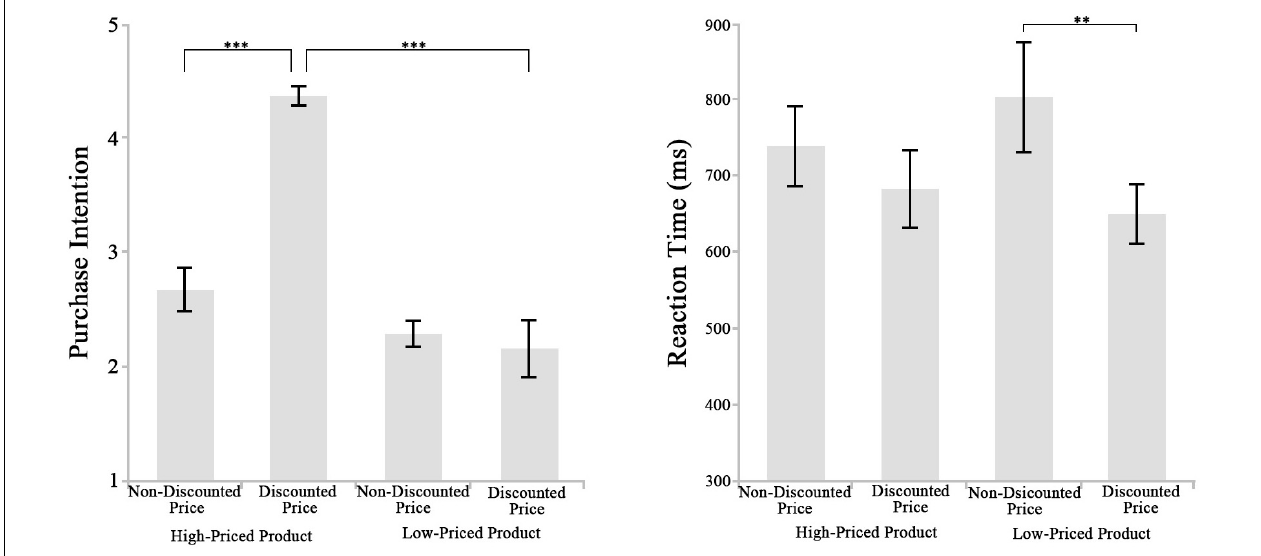
FIGURE 2 | Mean purchase intentions (left) and mean reaction times (right) for four conditions (high-priced product with discounted price or with non-discounted price, low-priced product with discounted price or with non-discounted price). The error bars suggest standard error of the mean. ** p < 0.01, *** p < 0.001. TABLE 1 | The ANOVA results of the rating task. High-priced product Low-priced product Main effect of